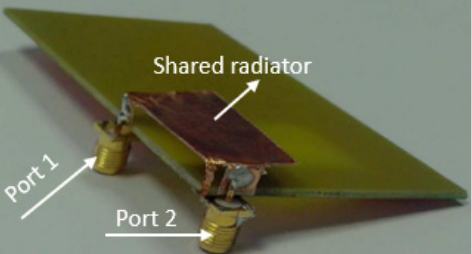
Figure 12. Fabricated two port PIFA MIMO antenna design with shared radiator [73].